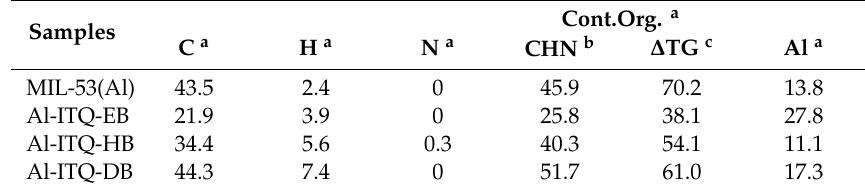
Table 1. Chemical analysis of the MIL-53(Al), Al-ITQ-EB, Al-ITQ-HB and Al-ITQ-DB materials. Samples